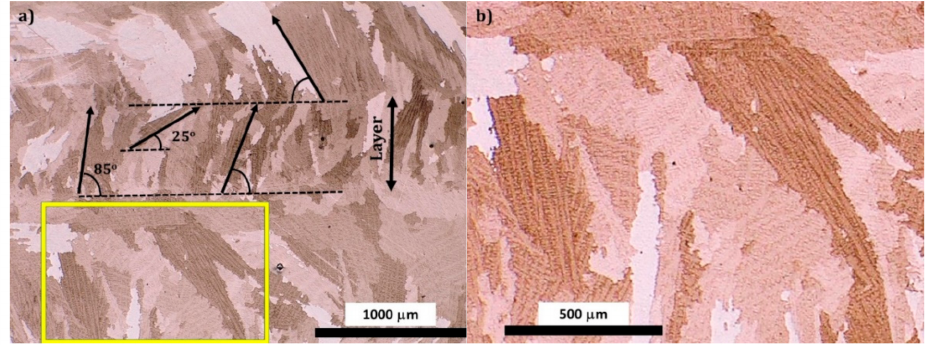
Figure 4. Optical micrographs of ( a ) bi-directionally deposited sample, and ( b ) higher magnification of the selected area in panel ( a ).